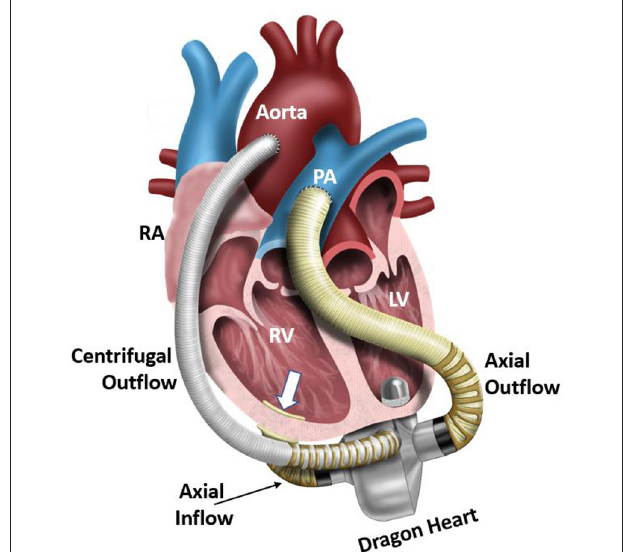
FIGURE 1 | Illustration of an implanted Dragon Heart hybrid continuous-flow blood pump technology. The centrifugal blood pump is designed to support the systemic circulation and left ventricle, and the axial flow blood pump is designed to support the pulmonary circulation and right ventricle. In this study, we focus on the design-build-test of the centrifugal blood pump component of this device. RA, right atrium; RV, right ventricle; LV, left ventricle; PA, pulmonary